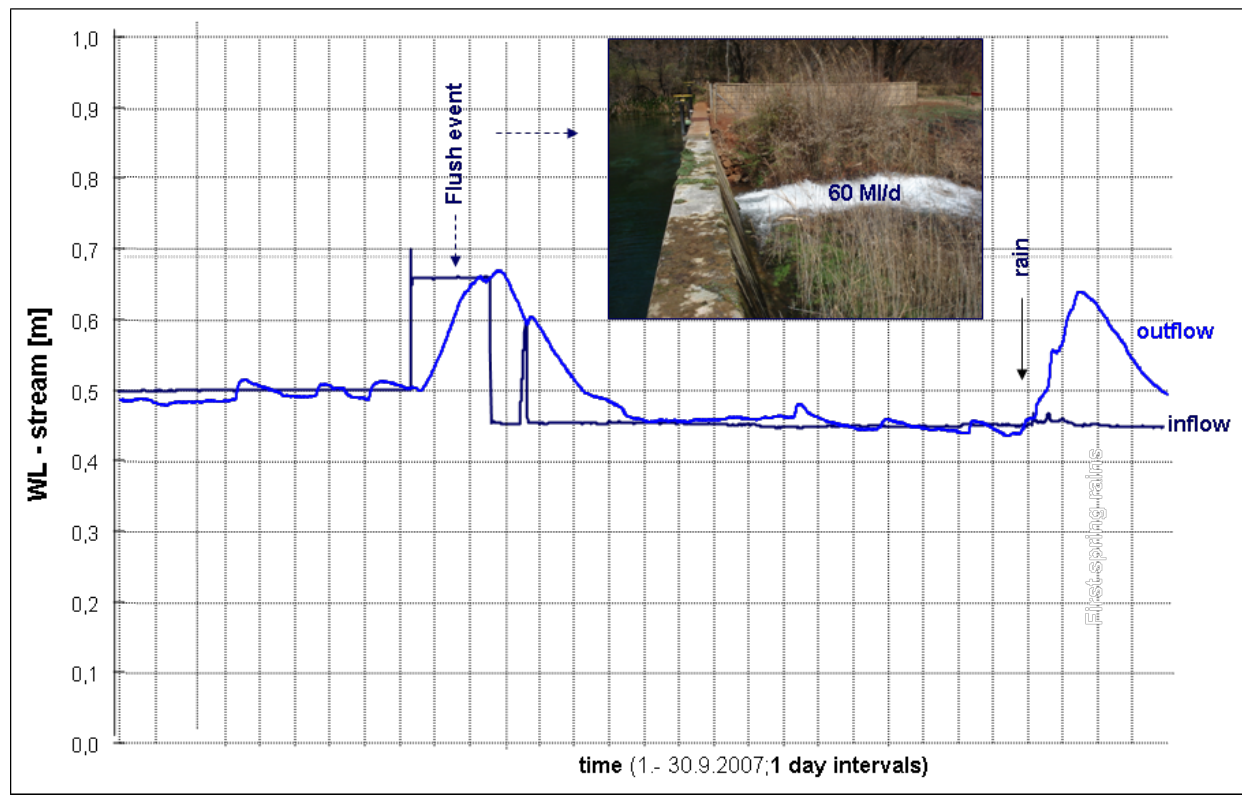
Figure 22. Comparison of water level changes in the Gerhard Minnebron stream at the inflow and the outflow of the wetland as observed during a flushing event and first spring